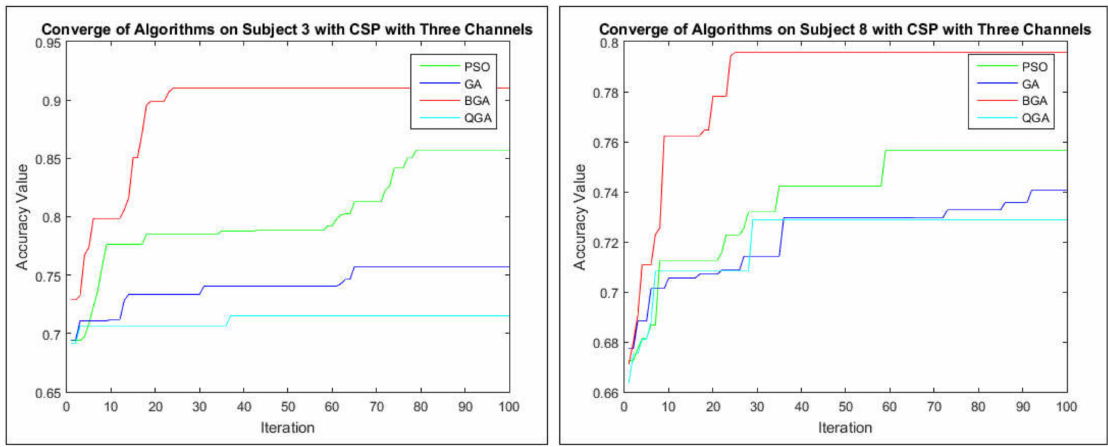
Figure 18. Converging of subjects 3 and 8 with algorithms on the seventh model scenario (CSP with three channels (PSO-CSP2, GA-CSP2, BGA-CSP2, and